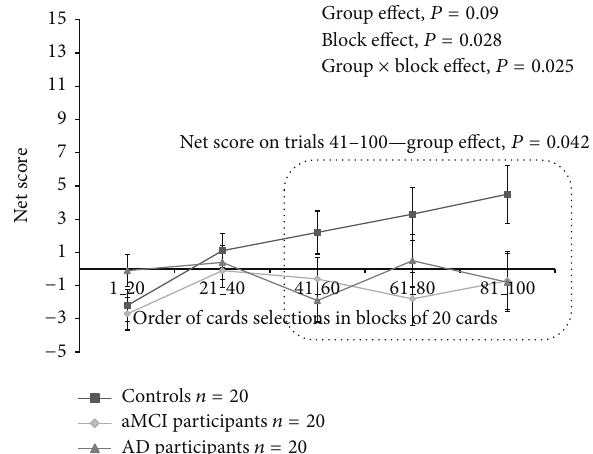
Figure 1: Iowa gambling task net scores for the 5 blocks, consisting of20cardsselectionsforcontrols,aMCI,andADparticipants.Mean ( ± SEM) are given.